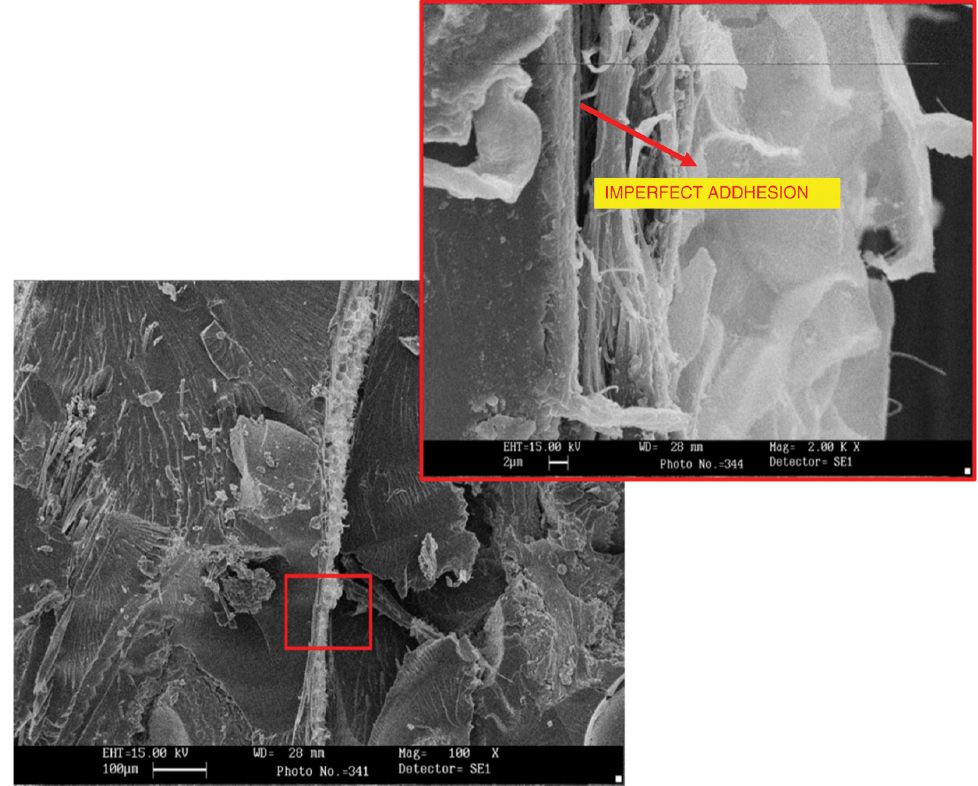
Figure 9: Scanning electron micrograph of 2.0% CR with 5.0% CFF composite.